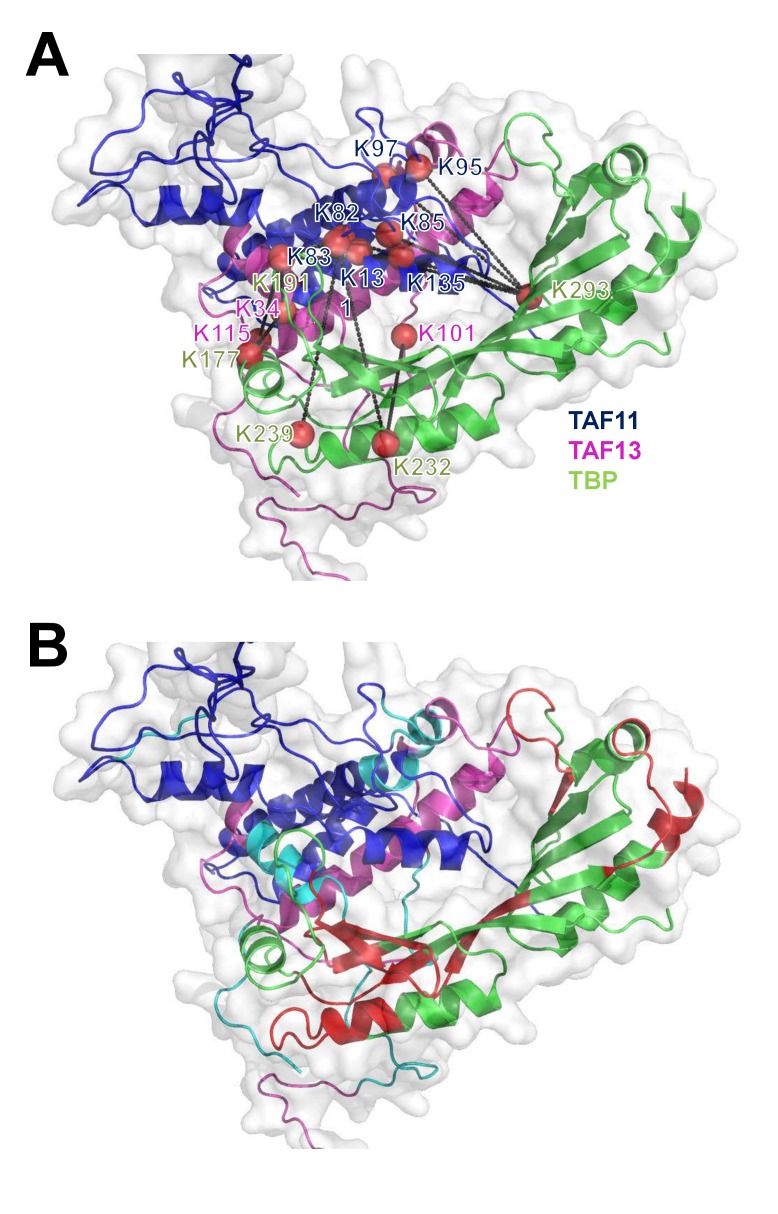
Mapping CLMS and HDX-MS data on TAF11/TAF13/TBP complex.(A) Cross-links identified by BS3 CLMS mapped on the TAF11/TAF13/TBP ternary complex. The current model satisfies >90% of all observed cross-links. Cross-linking sites are depicted as red balls. (B) Regions on TBP exhibiting changes in deuteration levels upon complex formation with TAF11/TAF13 are highlighted in red.